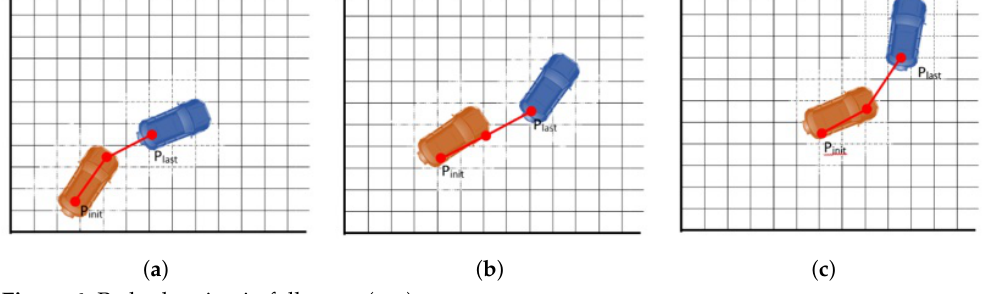
Figure 6. Path planning in followers ( a – c